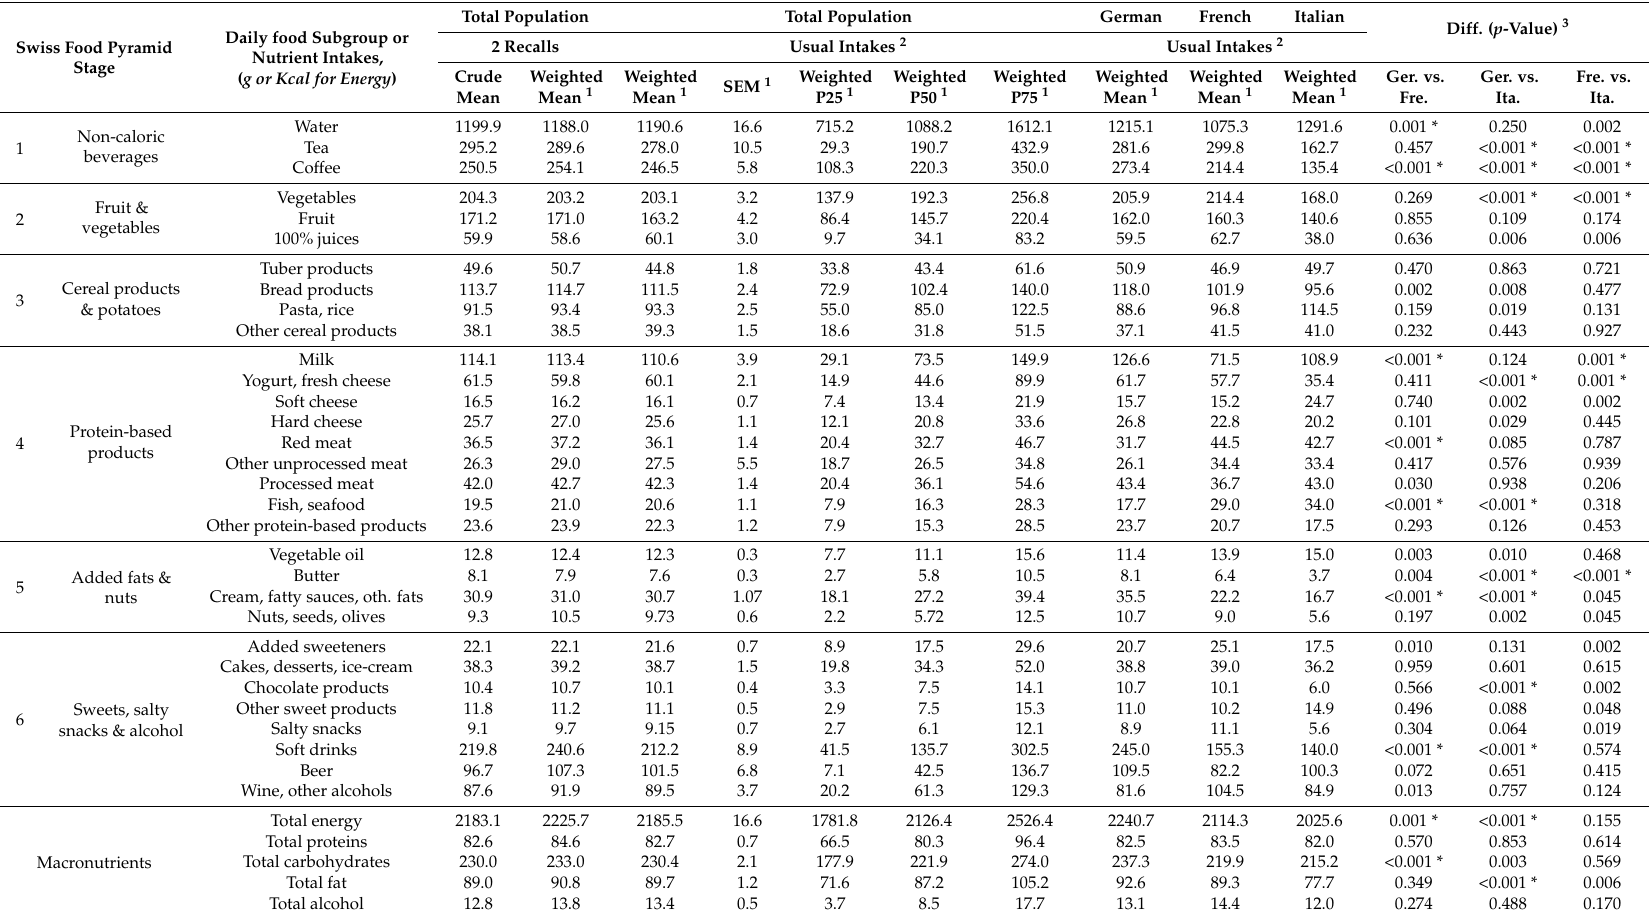
Table 3. Food subgroup and macronutrient intake, total, and by linguistic